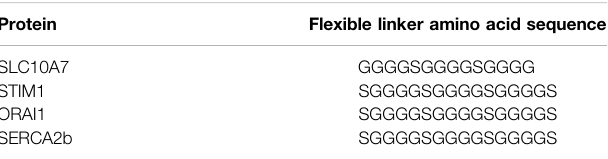
TABLE 1 | Flexible linker amino acid sequences inserted between the corresponding protein and the mScarlet fl uorescence tag in the pcDNA3.1 (+) vector.